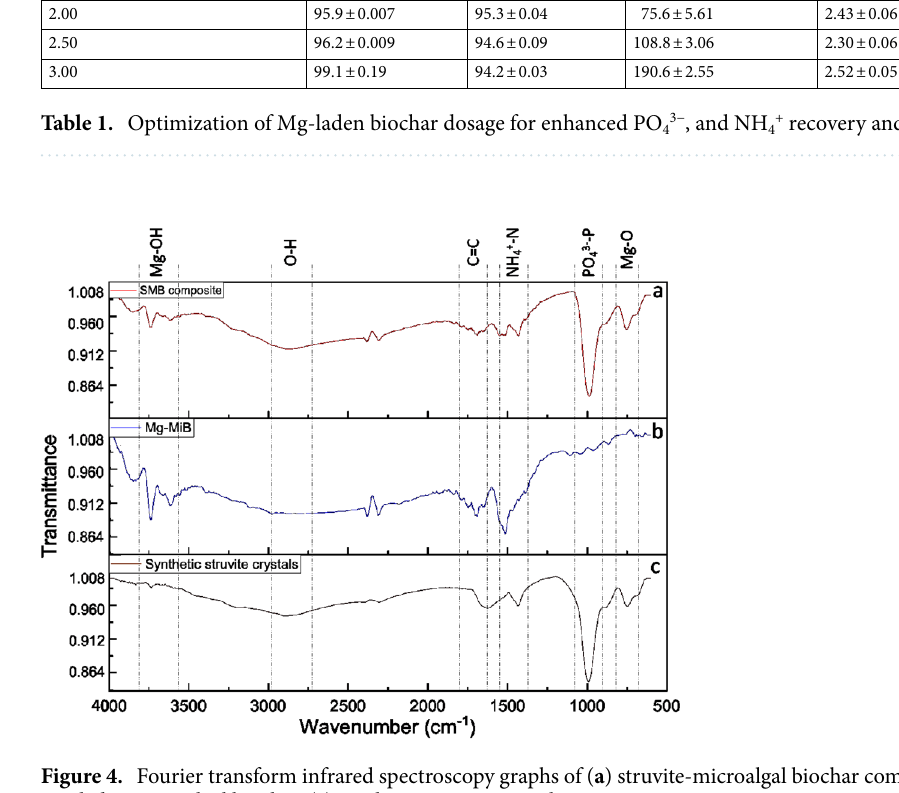
Figure 4. Fourier transform infrared spectroscopy graphs of ( a ) struvite-microalgal biochar composite. ( b ) Mg-laden microalgal biochar. ( c ) synthetic struvite